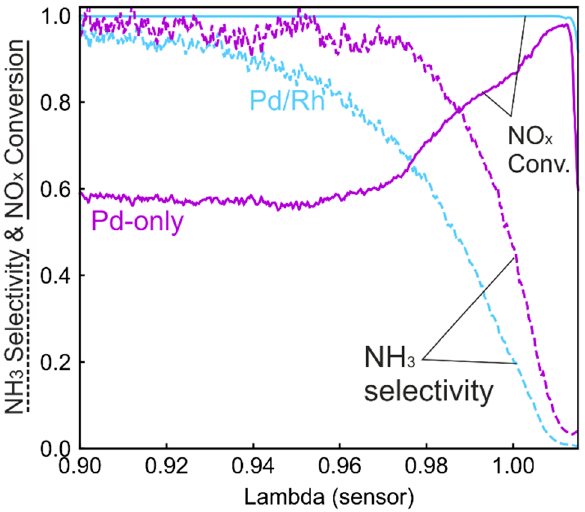
Figure 5. Comparison of NO x conversion and NH 3 selectivity during λ ramp-up in the Pd-only and Pd/Rh catalyst.